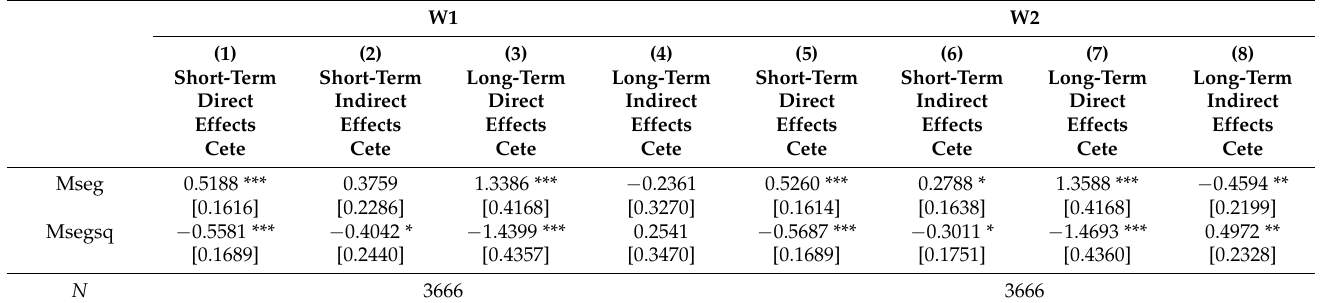
Table 7. Estimation of direct and indirect effects under different spatial weight